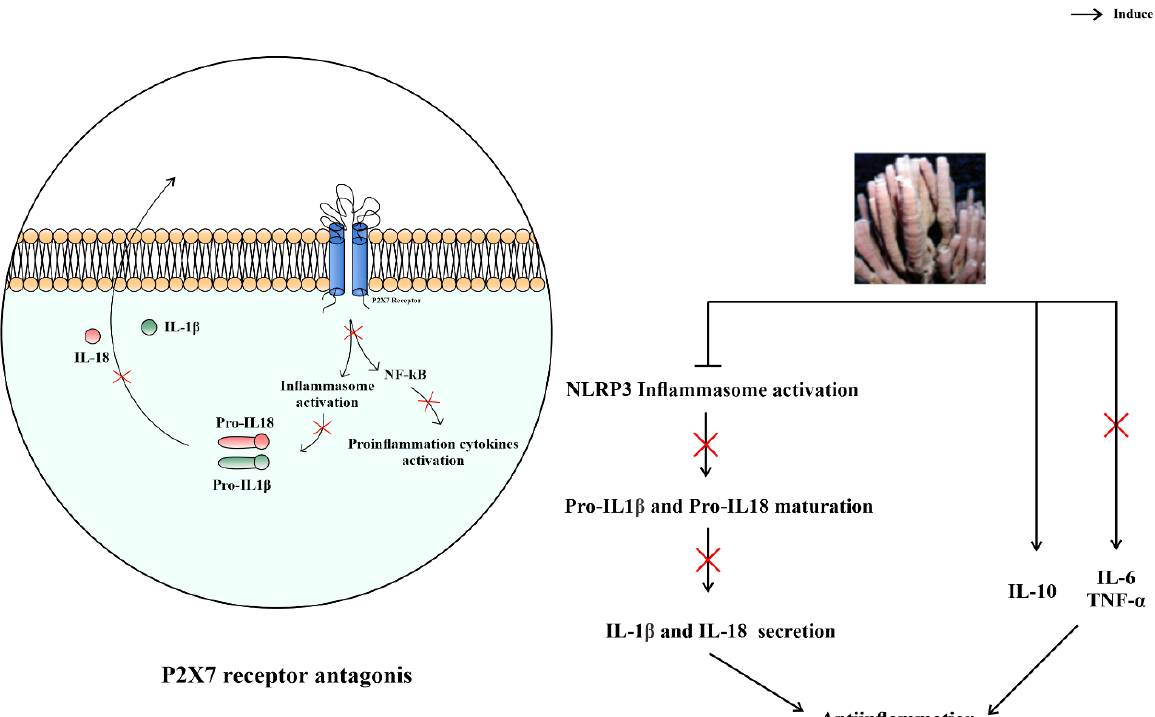
Figure 6. Prediction of anti-inflammatory mechanisms of compounds from the subgenus Callyspongia .